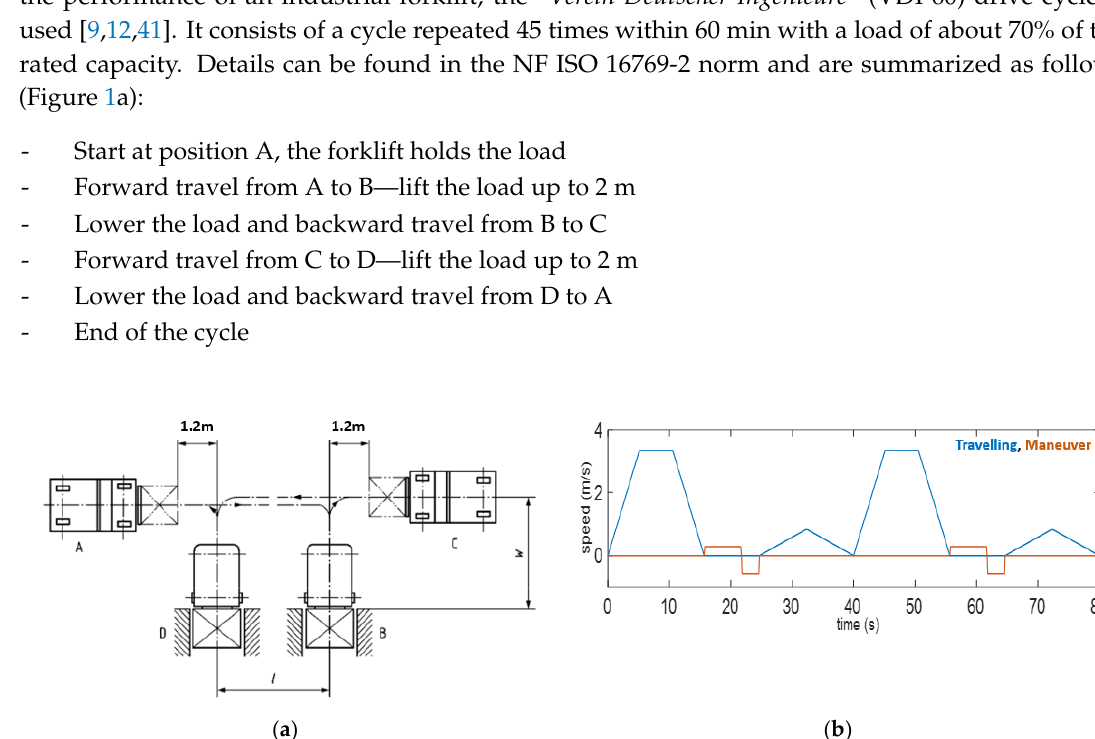
Table 1. Jungheinrich forklift dynamics.